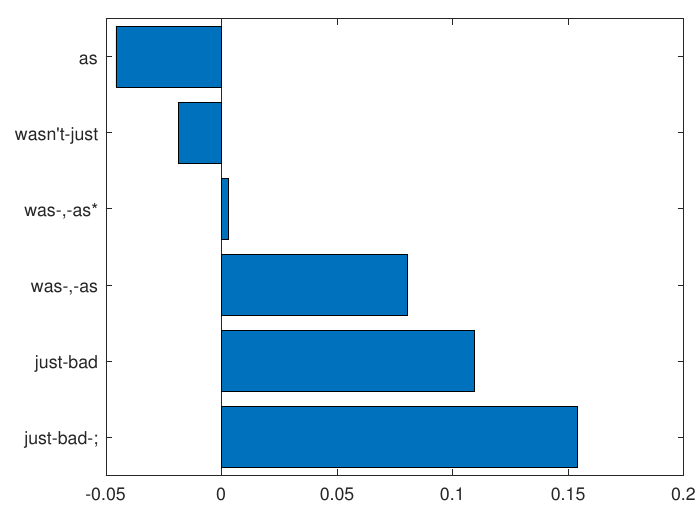
Figure 10. N-grams determined from R 26 and the following “tweet”: “the tuxedo wasn’t just bad; it was, as my friend david cross would call it, hungry-man portions of bad.” The sum of the n-grams linear contributions is 0.283.